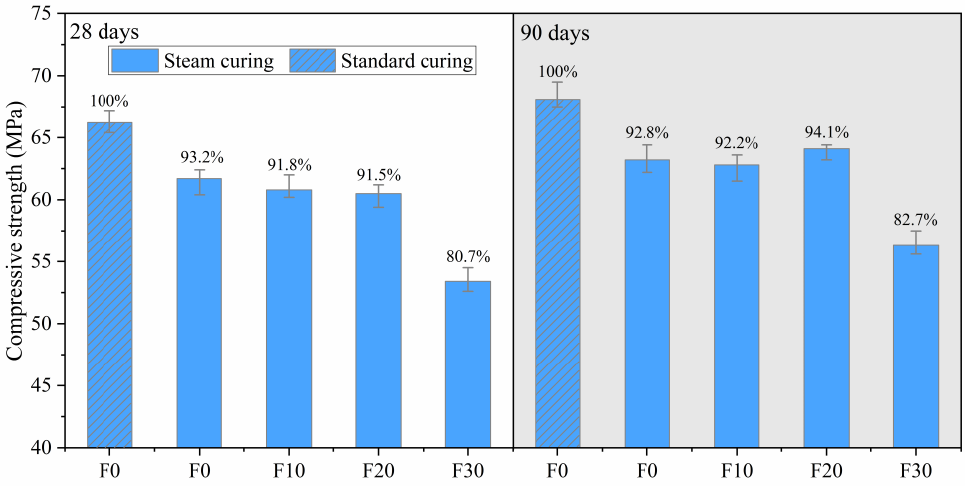
Figure 7. Compressive strength of concrete with different FA contents at 28 days and 90